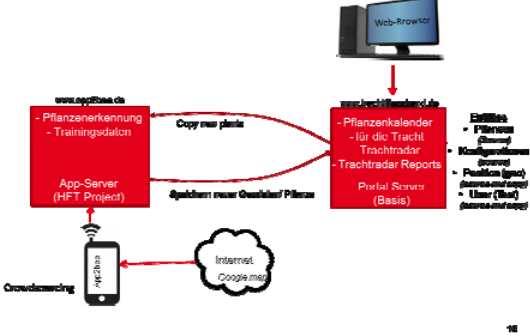
Figure 9: Web-portal and App-server (Source: Boris